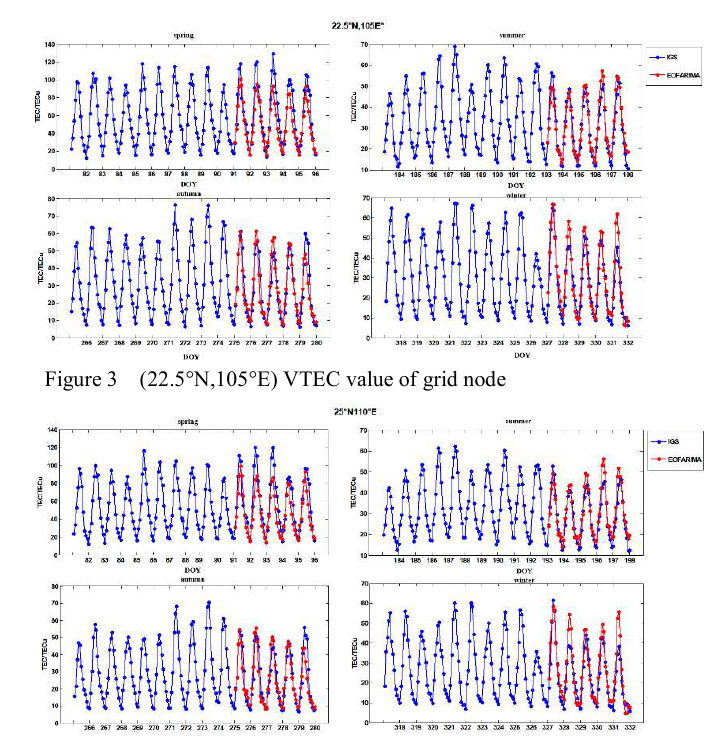
Figure 4 (25°N,110°E) VTEC value of grid